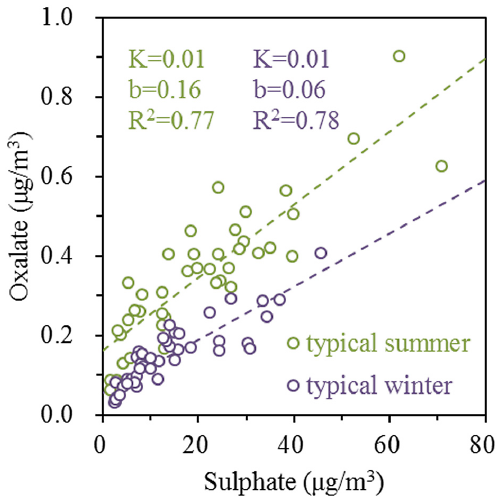
Fig. 6. Dependence of oxalate on sulfate during the typical sum- mer and winter period. Linear regression results are shown with K as slope and b as intercept, and results for summer and winter are marked by green and purple font, respectively.